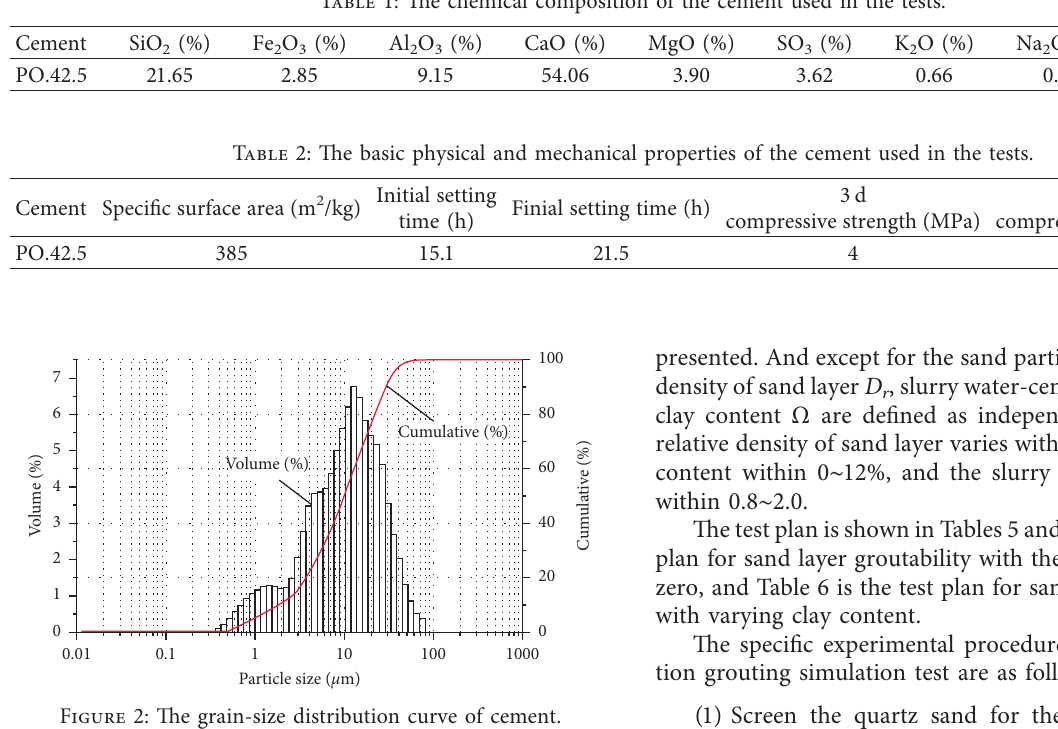
Figure 2: The grain-size distribution curve of cement. Table 3: Characteristic particle size of cement used in the tests.